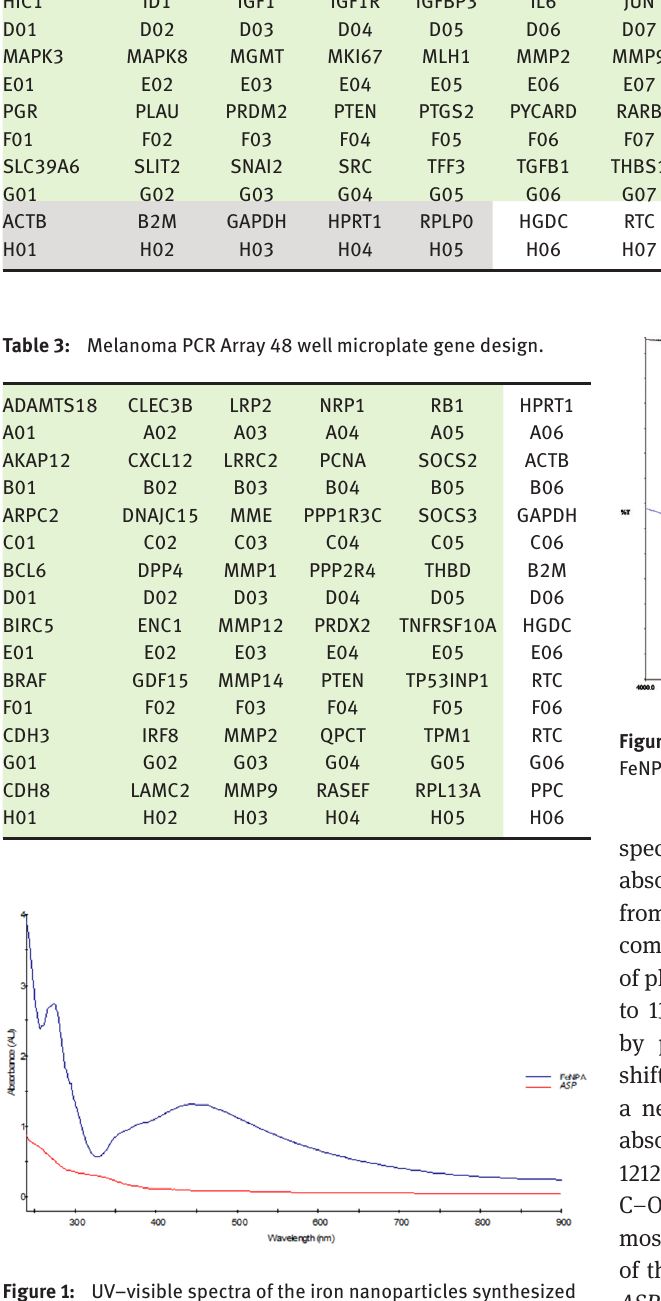
Figure 1: UV–visible spectra of the iron nanoparticles synthesized from Asphodelus aestivus extract and the aqueous extract of Asphodelus aestivus (FeNP :Fe nanoparticles prepared by A Asphodelus aestivus aqueous extract; ASP : the aqueous extract of the aerial part of Asphodelus aestivus ).